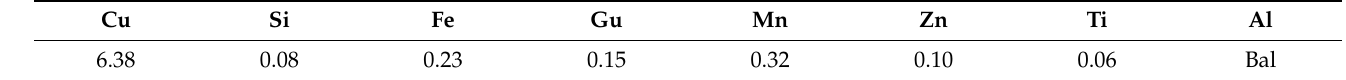
Table 1. Main chemical element composition of 2219 aluminum alloy (mass fraction, %).